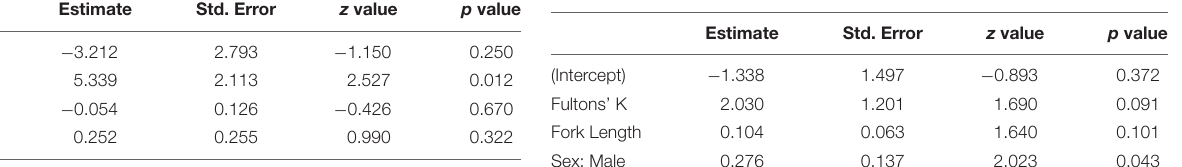
TABLE 2 | Parameter estimates for the negative binomial GLM where individual infection intensity (i.e., the number of P. tereticollis per infected smolt) is the response variable.